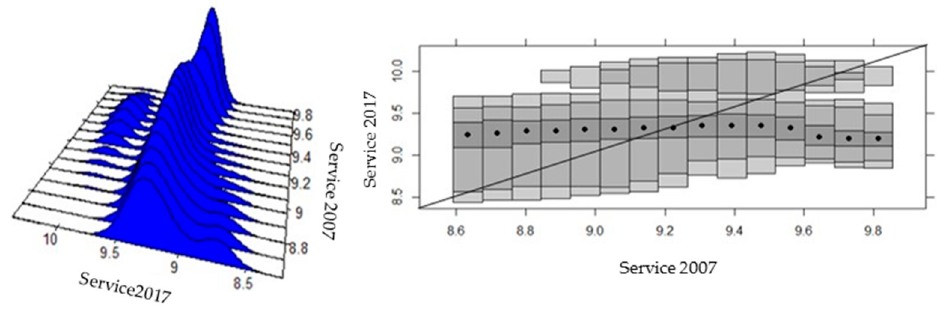
Figure 6. Intra-distribution dynamics of provincial productivity in the service sector, 2007–2017. Source: Own elaboration based on the Regional Accounts of the BCE [46]; ENEMDU surveys from the INEC [47] (several years) and stacked conditional density plot (SCD) in R.